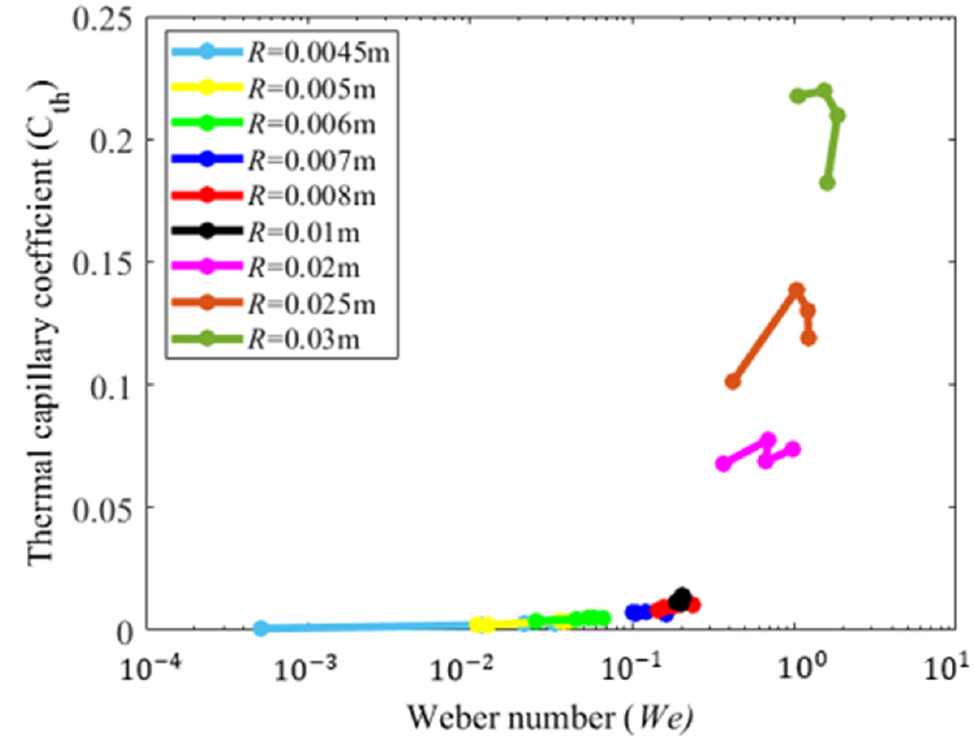
Figure 10. Relation between thermo-capillary coefficient ( C Th ) and the Weber number ( We ). For bubble sizes in the range of 0.0045 m < R ≤ 0.007 m, Figure 11 shows the thermo- capillary coefficient ( C Th ) vs. the Weber number ( We ) for R = 0.0045 m. It is noted that both the Weber number and thermo-capillary coefficient increase when ∆ T increases.